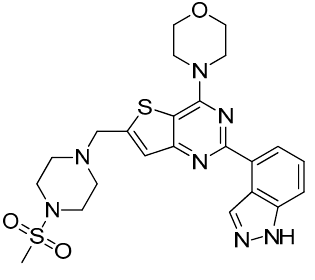
Figure 1. Structure of GDC-0941.